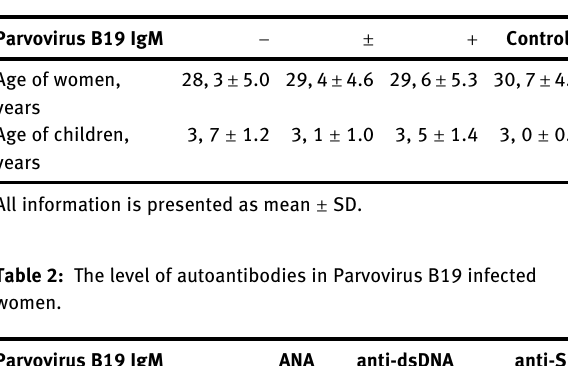
Table  : Age information of included patients.